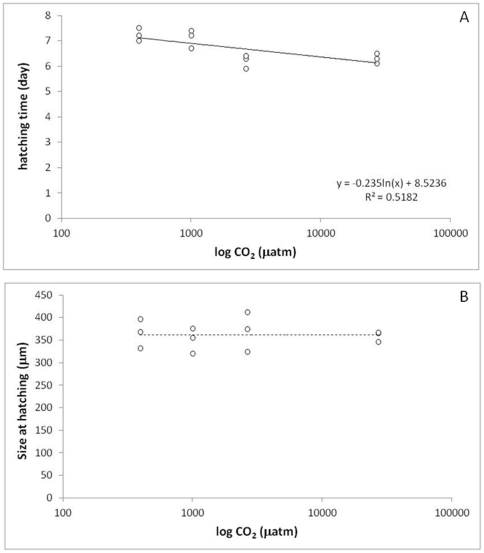
Impact of a range of pCO2 on: A. median hatching time; B. size of the juvenile at hatching (Experiment 1).A significant logarithmic relationships was observed between pCO2 and hatching time of cocoons (F = 10.76, p<0.008) but not between pCO2 and juvenile size at hatching time within the range of tested pCO2 (F = 0.01, p<0.97).